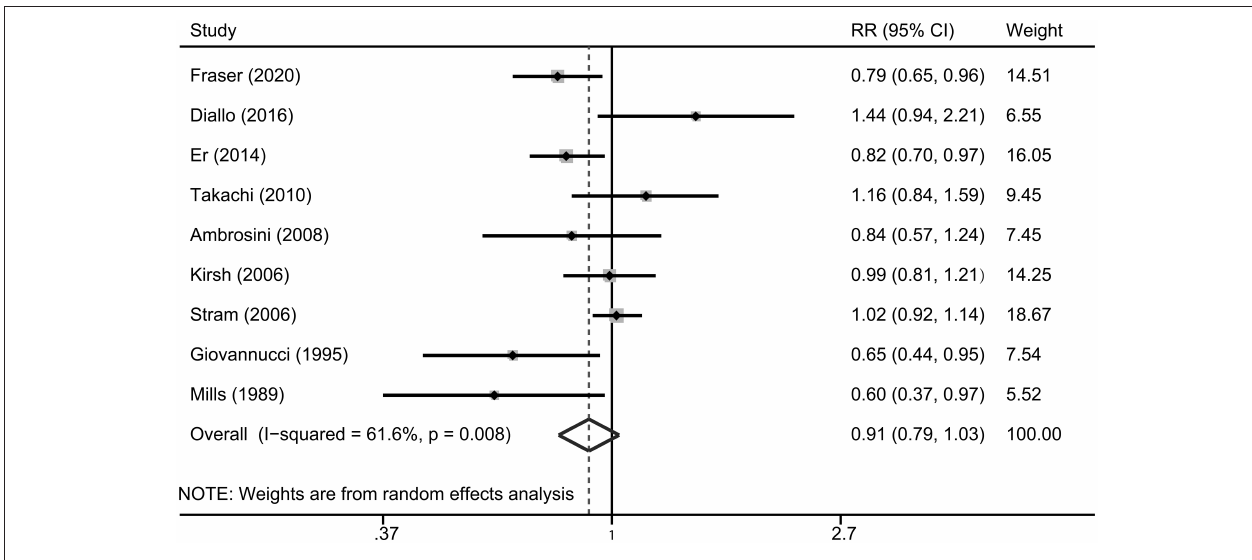
FIGURE 2 | A forest plot showing risk estimates of the association between tomato consumption and prostate cancer risk.